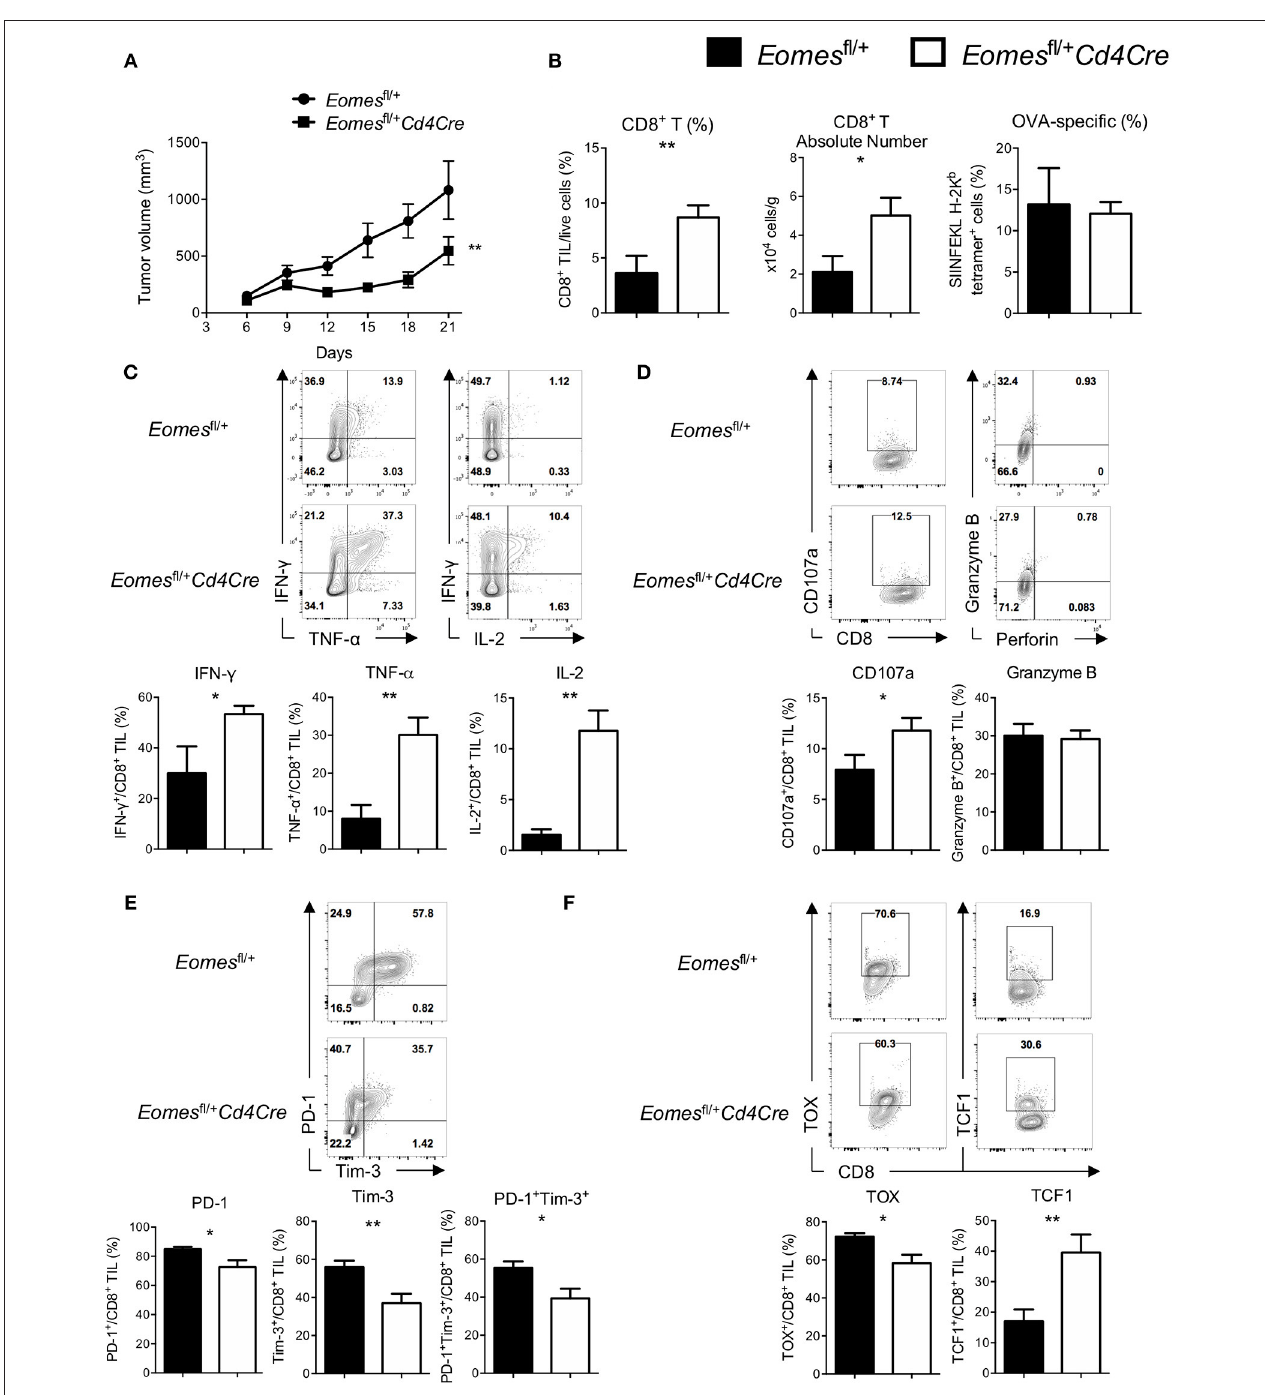
FIGURE 3 | High amounts of Eomes in CD8 + TILs drive T cell exhaustion. (A) Mean tumor volume of intradermal E.G7 implants in Eomes fl / + vs. Eomes fl / + Cd4Cre mice. (B) Summary histograms showing percentage of CD8 + TILs in total live cells, absolute number of CD8 + T cells in the tumor and frequency of OVA-specific CD8 + T (stained by SIINFEKL H-2K b tetramer) in total CD8 + TILs from Eomes fl / + vs. Eomes fl / + Cd4Cre mice on Day 21. (C) Production of IFN- γ , TNF- α and IL-2 by CD8 + TILs from Eomes fl / + vs. Eomes fl / + Cd4Cre mice on Day 21 after PMA/ionomycin stimulation. (D) Baseline surface expression of CD107a and PMA/ionomycin-stimulated expression of intracellular Granzyme B in CD8 + TILs from Eomes fl / + vs. Eomes fl / + Cd4Cre mice on Day 21. (E) Representative flow cytometric analysis and summary data of PD-1 and Tim-3 co-expression on CD8 + TILs from Eomes fl / + vs. Eomes fl / + Cd4Cre mice on Day 21. (F) Expression of TOX and TCF1 in CD8 + TILs from Eomes fl / + vs. Eomes fl / + Cd4Cre mice on Day 21 measured by intracellular flow cytometric analysis. Data are pooled from 2 independent experiments with 5–8 mice per group. Error bars denote mean ± SEM. Statistical analysis was performed using linear regression (A) or unpaired Student’s t -test (others). * p < 0.05, ** p < 0.01.